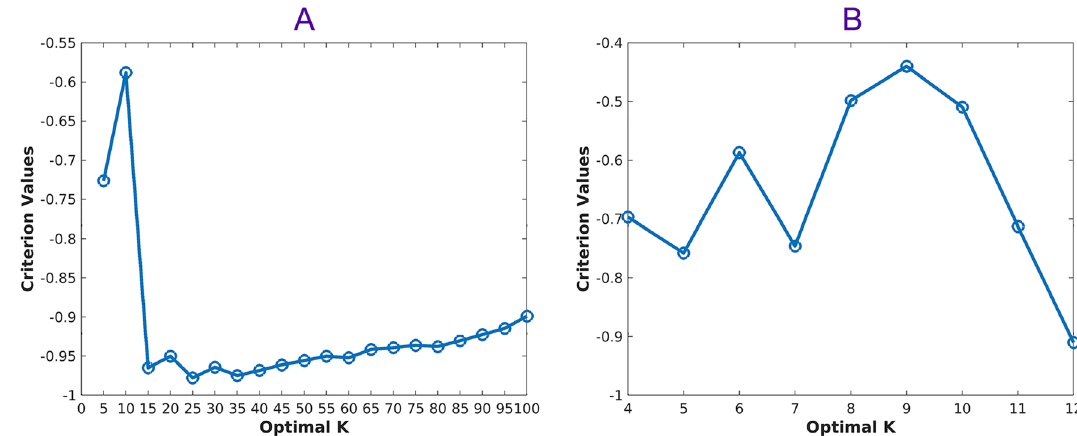
Figure 5. Optimal K using the Silhouette algorithm. ( A ) First, we run the algorithm every 5th point between 5 and 100 and then ( B ) run the algorithm between 4 and 12 to find the optimal K = 9 for the K means